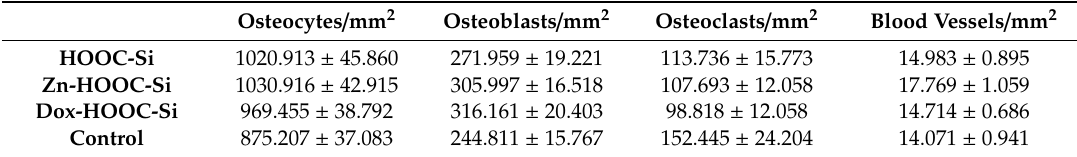
Table 5. Bone cells and blood vessels counts (units / mm 2 ) within the new bone created at the region of interest (Mean ± Standard Error).